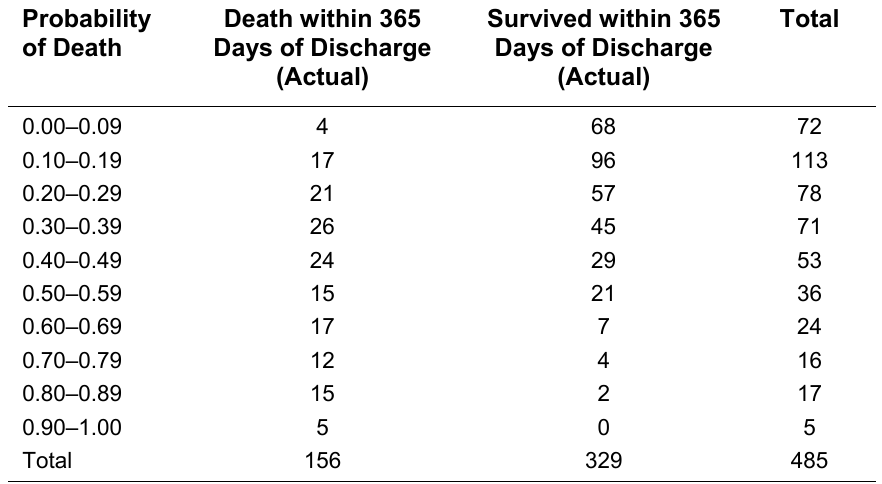
Probability Distribution of Outcomes for 365-Day Logistic Regression Model — Administrative and Clinical Data Testing